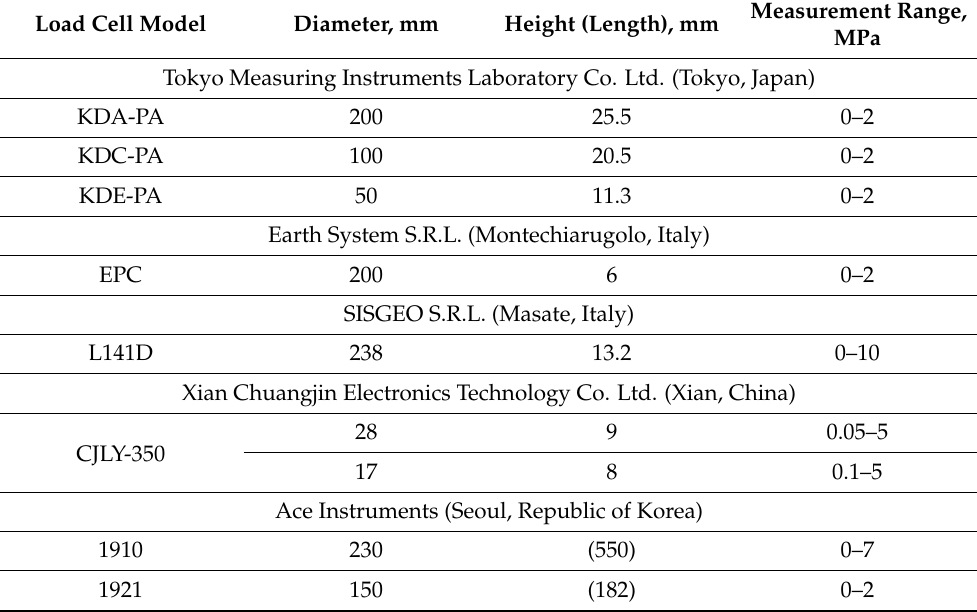
Table 1. Technical characteristics of load